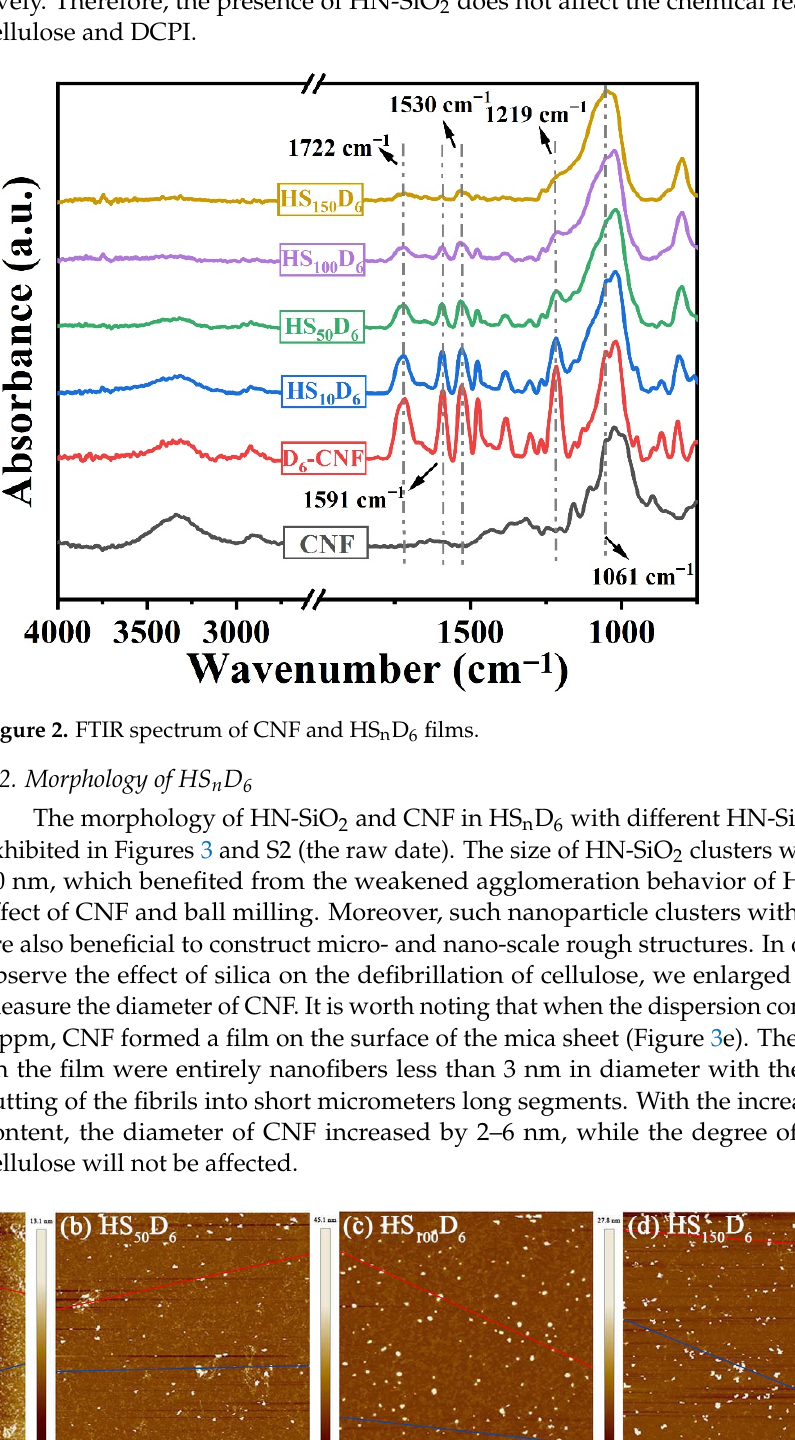
Figure 3. The AFM images of morphology of ( a ) D 6 -CNF and HN-SiO 2 in ( b ) HS 50 D 6 , ( c ) HS 100 D 6 , and ( d ) HS 150 D 6 . The AFM images of CNF in ( e ) D 6 -CNF, ( f ) HS 50 D 6 , ( g ) HS 100 D 6 , and ( h ) HS 150 D 6 . 3.3. Morphology of CNF/HN-SiO 2 Films To explore the effect of ultrasonic and ball-milling methods on the interaction be- tween nanoparticles and CNF, the film morphologies of HS 150 D 6 and D 6 + HS 150 were char- acterized (Figure S3 is the raw date). As shown in Figure 4a–d, the HN-SiO 2 clusters in D 6 + HS 150 were larger than those in HS 150 D 6 , which indicated that the effect of ball milling and CNF could hinder the agglomeration behavior of HN-SiO 2 . This is because with the formation of CNF, HN-SiO 2 can be further dispersed on the CNF surface by ball milling. Figure 4e shows the CNF/HN-SiO 2 film close to the glass, i.e., the morphology of the film formed at the interface. Figure 4f shows the cross-sectional HN-SiO 2 distribution in com- posite films. It can be seen that the CNF uniformly binds the nanoparticles together during film formation, showing a situation of stacking layer by layer. When the composite forms a film, the CNF first tends to form a film at the interface and then adhere the nanoparticles to the surface. Therefore, the modification and defibrillation of cellulose by ball milling will further promote the dispersion of nanoparticles, which is advantageous compared with conventional dispersion methods.